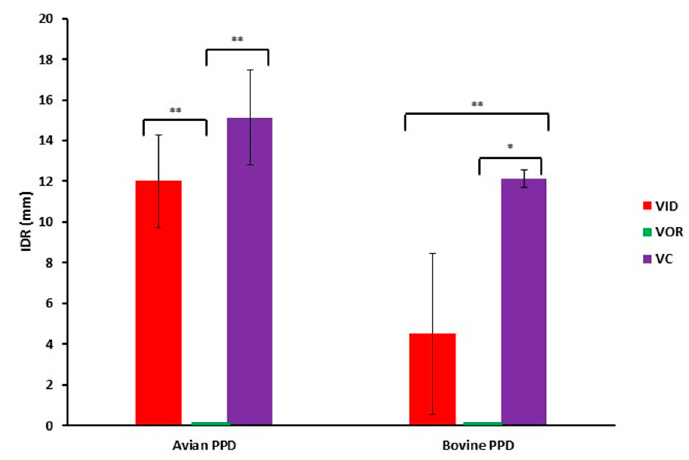
Figure 5. Mean skin reaction measured values to avian and bovine purified protein derivative (PPD) after sensitization in experimental intradermal vaccine (VID), experimental oral vaccine (VOR) and control vaccine (VC) animal groups. Error bars represent the standard error of the mean. * p < 0.01; ** p < 0.001.